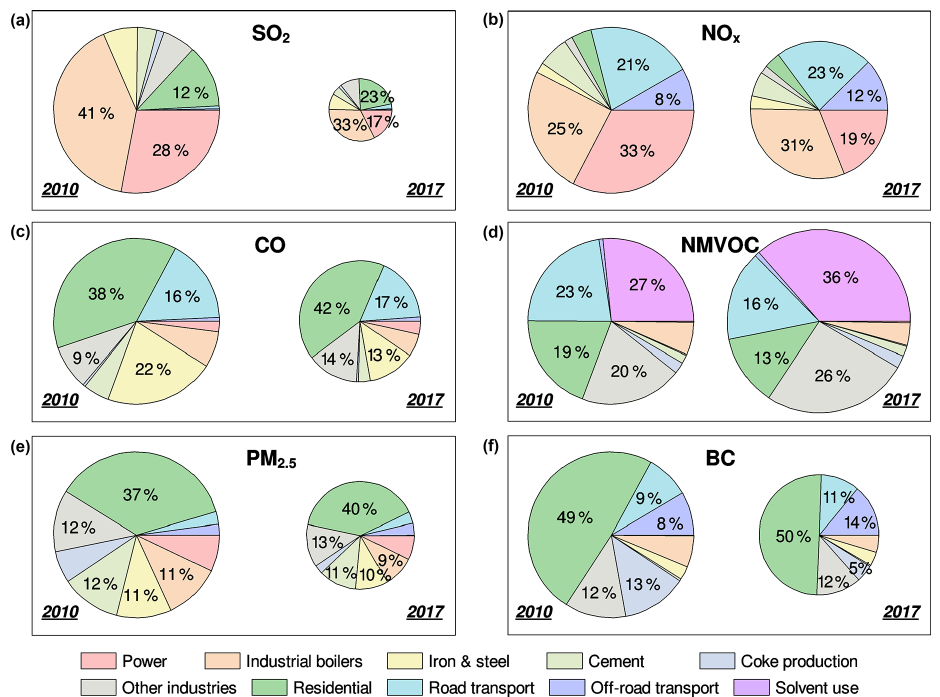
Figure 9. Changes in emission percentages across source sectors from 2010 to 2017. The species plotted here include (a) SO 2 , (b) NO x , (c) CO, (d) NMVOCs, (e) PM 2 . 5 , and (f) BC. For each pollutant, the relative change in the radius of the pie chart from 2010 to 2017 is proportional to the change in emissions.